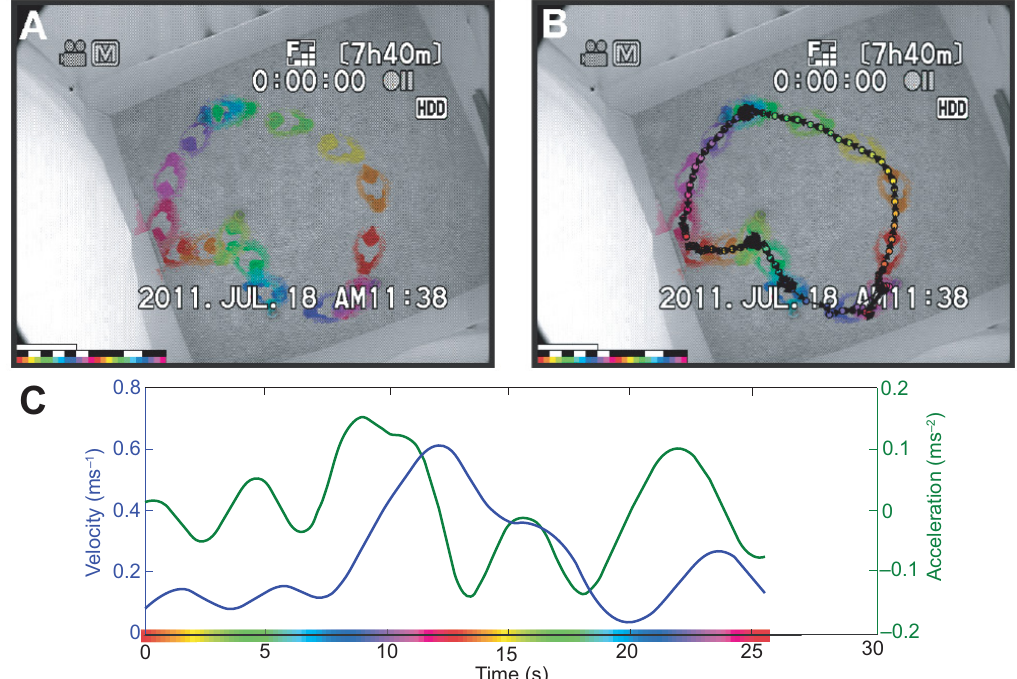
Figure 1. Visualizing and quantifying movement data from a single trial of a pigeon navigating an arena with four food cups. ( A ) Spectral time-lapse (STL) image of the trial, sampled at 1 pps. First bar in bottom left corresponds to 10 seconds; second bar illustrates which frames highly overlapped with adjacent frames; third bar shows time-color mapping used. ( B ) Path overlaid on the STL image, sampled at 6 pps. ( C ) Velocity-acceleration plot of same movement